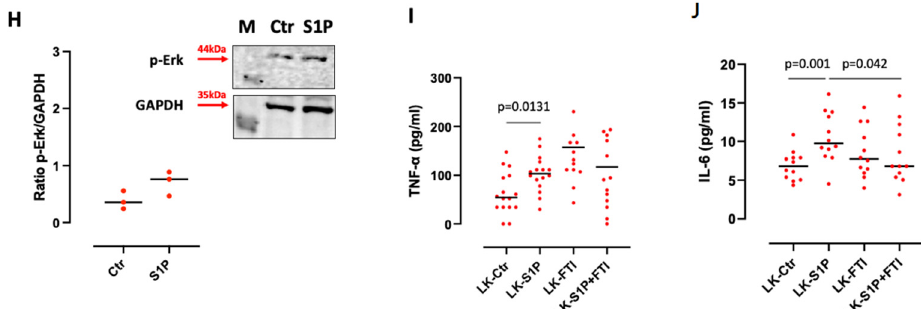
Figure 5. Akt/mTOR and K-Ras/Erk pathways were involved in the S1P-induced IL-6 release. One- hour S1P-treated lung cancer (LK)-derived PBMCs over-expressed phospho-IkB α (p-IkB α ; 40kDa) ( A ) and phospho-NF- κ B p65 (p-p65; 65kDa) ( B ) compared to control. GAPDH was used as loading control. M refers to the protein molecular weight marker. The experiment was repeated four times. NF- κ B inhibition by means of MG132 (10 µM) did not reduce the release of TNF- α (( C ), n = 11) and IL-6 (( D ), n = 12) from LK-isolated PBMCs after S1P addition. ( E ) One-hour S1P-treated LK-derived PBMCs over-expressed phospho-Akt (p-Akt; 60kDa) compared to control. GAPDH was used as a loading protein. M refers to the protein molecular weight marker. The experiment was repeated four times. The inhibition of mTOR by means of Rapamicin (Rap, 100 ng/mL) reduced IL-6 (( G ), n = 12), but not S1P-induced TNF- α release (( F ), n = 16). ( H ) One-hour S1P-treated LK-derived PBMCs over-expressed phopho-Erk (p-Erk; 44 kDa) compared to control (Ctr). GAPDH was used as loading protein. M refers to protein molecular weight marker. The experiment was repeated three times. The inhibition of K-Ras by means of FTI-276 (FTI, 2 µg/mL) reduced IL-6 (( L ), n = 12), but not S1P- induced TNF- α release (( I ), n = 16). All samples were matched-pairs. Data are represented as scatter dot plots indicating the median (confidence interval = 95%). Statistical differences were assessed by means of two-tailed Wilcoxon matched-pairs signed rank test.